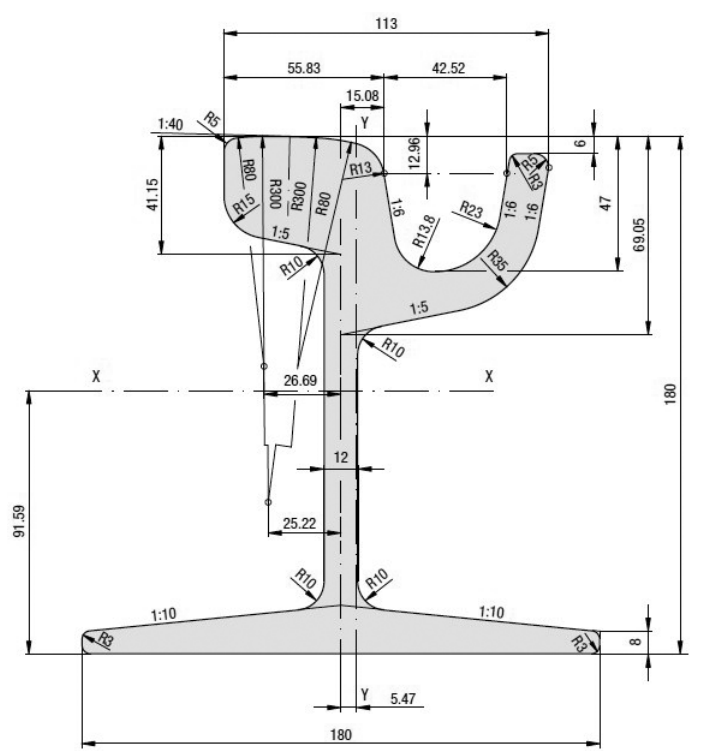
Figure 10. Cross-section of 59R2 rail profile (VoestAlpine Schienen